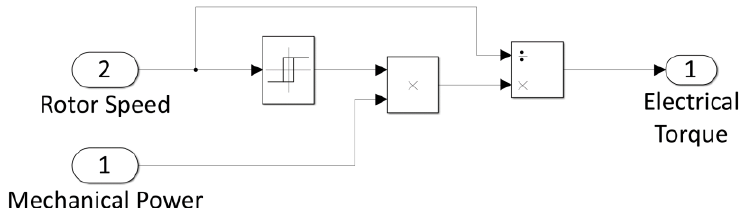
Figure 14. Detail of the on-off constant rotational speed control law.